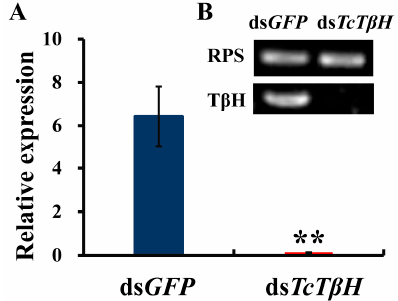
Figure 5. The RNA interference (RNAi) of TcT β H . ( A ) The RNAi efficiency was tested by qRT-PCR (the result comes from software of qbase). Data were obtained by analyzing three independent groups of four individuals (two females; two males) per group; ( B ) The confirmation of RNAi efficiency by RT-PCR. Double asterisks represent a significant difference by an independent t test ( n = 3, **, p < 0.01), the target gene of TcT β H was carried out with 32 cycles and the reference gene TcrpS was carried out with 27 cycles.